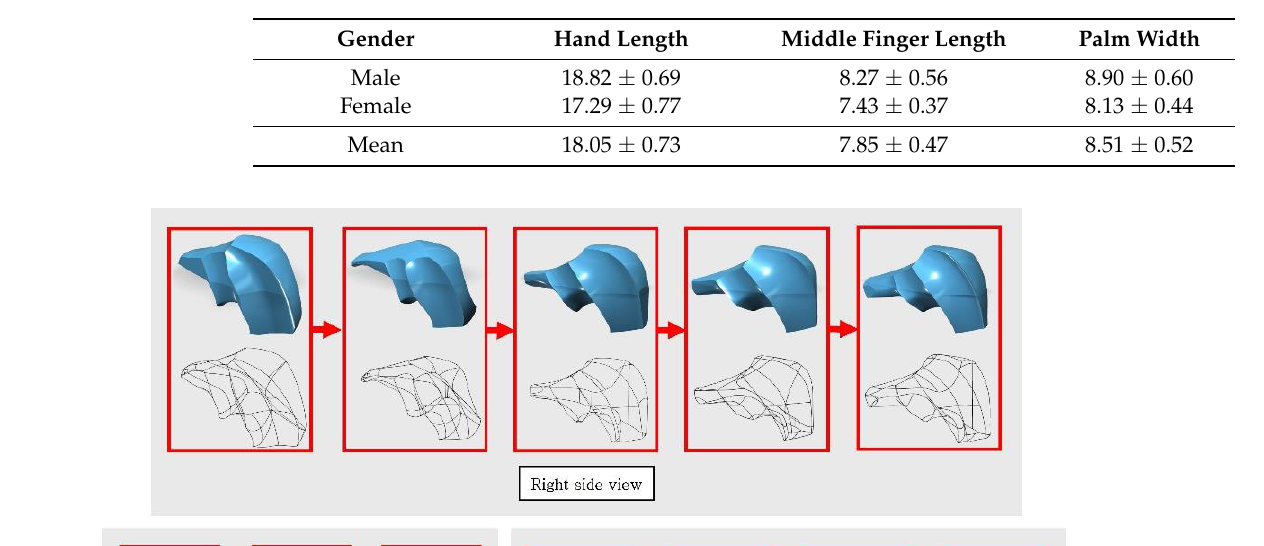
Table 2. Satisfaction items for the WAD evaluation instrument.